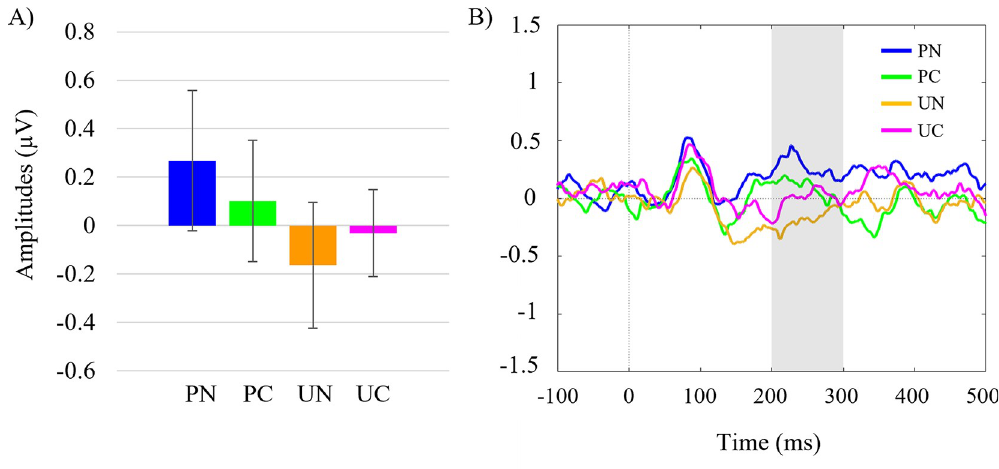
Fig 3. Grand average N2pc amplitudes. A) Grand averaged N2pc amplitudes ( μ V) pooled across hemispheres for all conditions (pooled contralateral activity minus pooled ipsilateral activity). B) Grand averaged ERP amplitudes ( μ V) of N2pc difference waves for all four conditions. Error-bars denote 95% confidence intervals calculated for repeated measures using the Cousineau-Morey Method [53]. Grey panels indicate the time windows tested of the N2pc component from 200-300ms. PN = predictable non-cued, PC = predictable cued, UN = unpredictable non-cued, and UC = unpredictable cued trials.